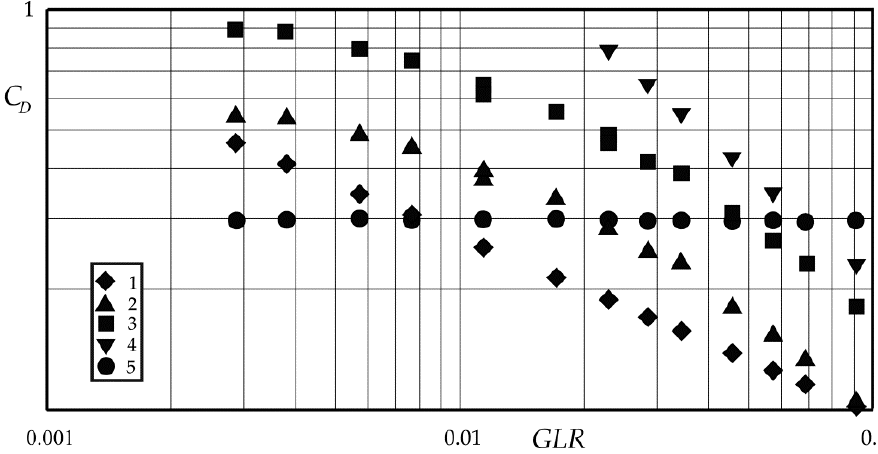
Figure 11. Summary of literature values of the discharge coefficient ( d 0 = 0.002 m; l 0 / d 0 = 1; β = 0°) [7]: 1-Chen and Lefebvre [96], 2-Jedelsky and Jicha [98], 3-Ochowiak [1], 4-Ochowiak et al. [44], 5- Ramamurthi et al. [97].